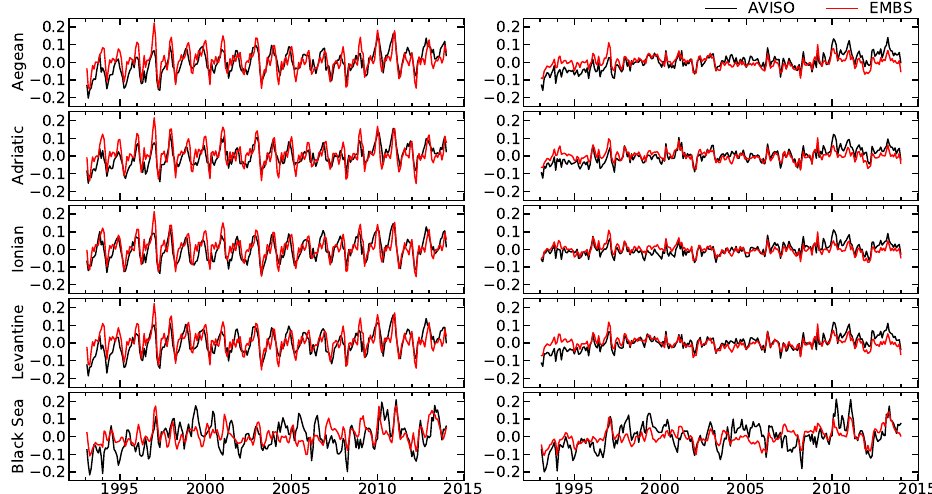
Figure 7. At the left column, time-series of spatially-averaged, zero-centered ADT in different sub-basins, for AVISO satellite reanalysis (black) and EMBS simulation (red). At the right column, as above with the seasonal cycle removed (deseasoned). All values in meters (m).